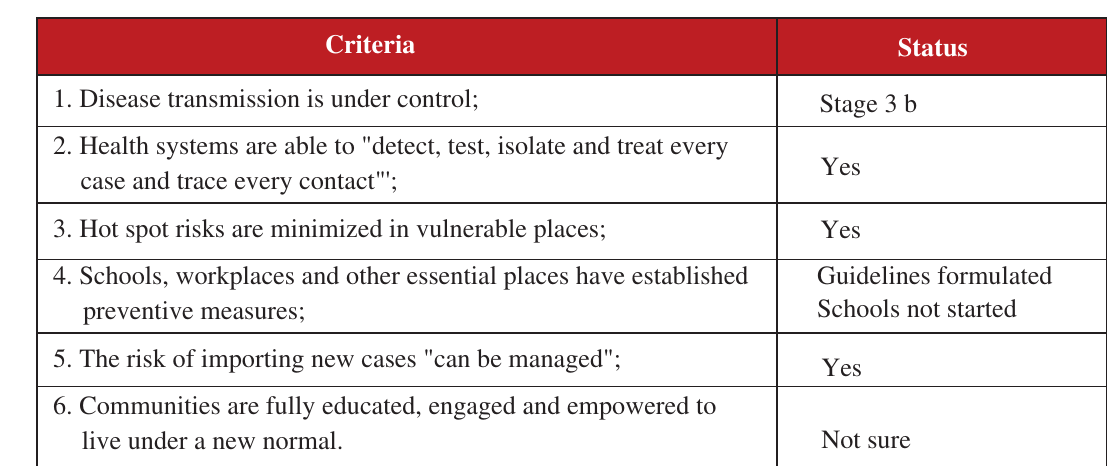
Table 2: Status of WHO criteria in relation to Colombo Municipality